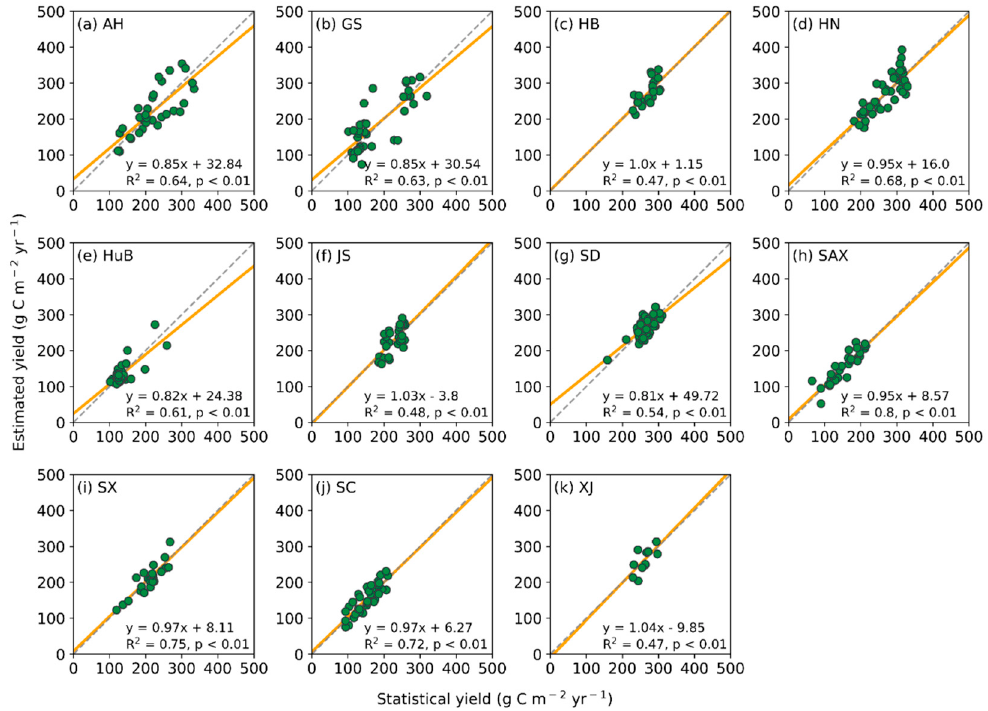
Figure 4. Statistical and estimated yield at the municipal scale during 2016–2018. The green dots represent the municipalities of the corresponding province. The yellow solid lines are the regression lines, and the grey short-dashed lines are the 1:1 lines. ( a – k ) show the correlation between statistical and estimated yield at municipal scale during 2016–2018 in AH, GS, HB, HN, HuB, JS, SD, SAX, SX, SC and XJ provinces, respectively.